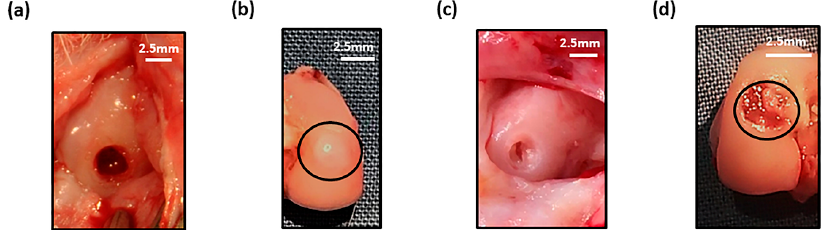
Figure 6. Macroscopic image of ( a ) empty defect immediately after creation and at ( b ) 6 weeks (defect cricled) post-surgery. ( c ) Cleaned defect prior to hydrogel implantation and ( d ) presence of hydrogel (black circle) in defect after one week in the joint.